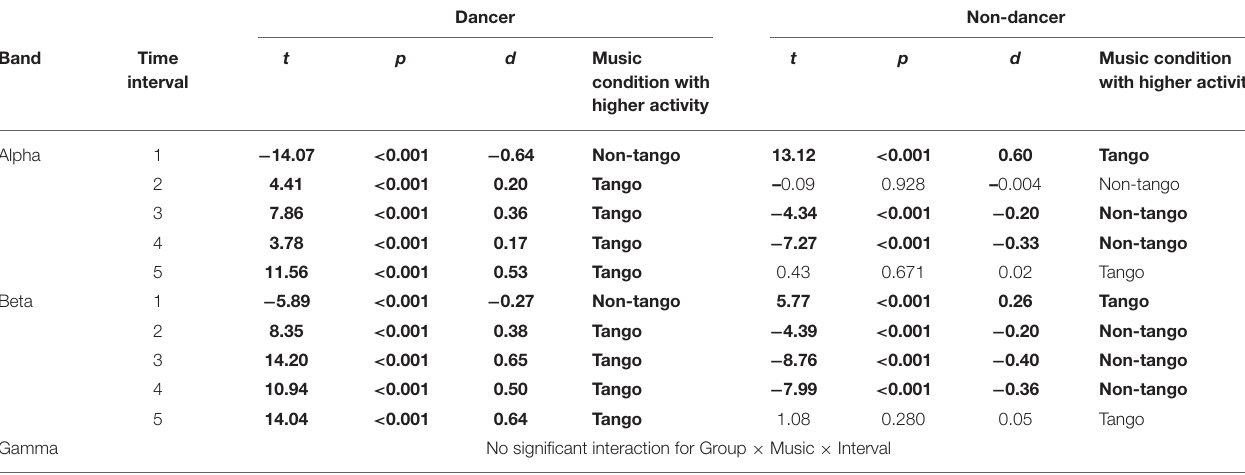
Gamma No significant interaction for Group × Music × Interval Bonferroni-corrected paired-samples t-tests (t) compared levels of Music within each Interval per Group. That is, tango minus non-tango in dancers, and tango minus non-tango in non-dancers. Positive t-values indicate higher activity in the tango condition relative to non-tango, while negative t-values indicate the reverse. Significant comparisons (p-values < 0.05) are in boldface. Cohen’s d indicates effect size that can be interpreted qualitatively as follows (Cohen, 1988): 0.2 small, 0.5 medium, 0.8